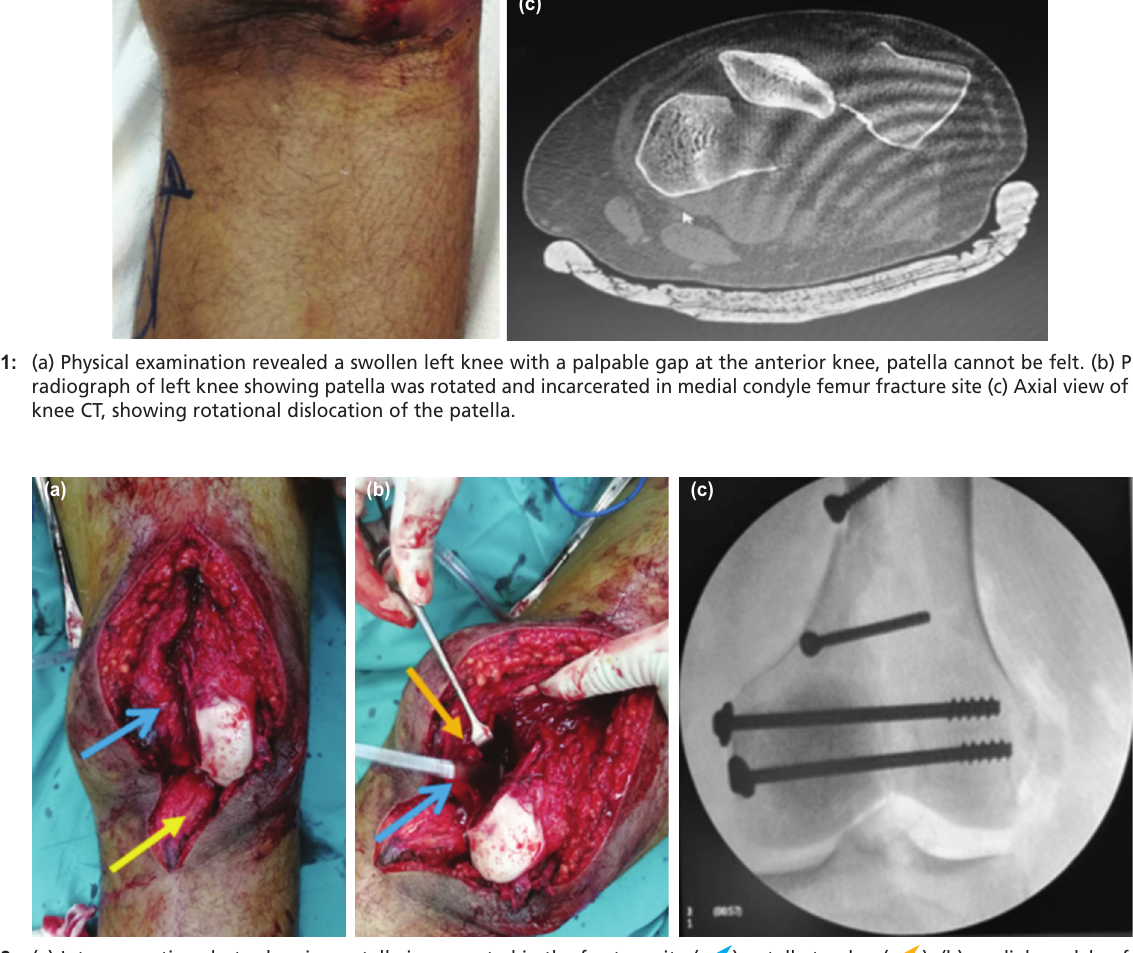
(a) Intra-operative photo showing patella incarcerated in the fracture site ( ) patella tendon ( ), (b) medial condyle of the Fig. 2: femur was retracted ( ) to disengage the incarcerated patella ( ), (c) after disengagement of the patella, medial condyle of the femur was able to be restored and fixed with lag screws, reduction checked under image